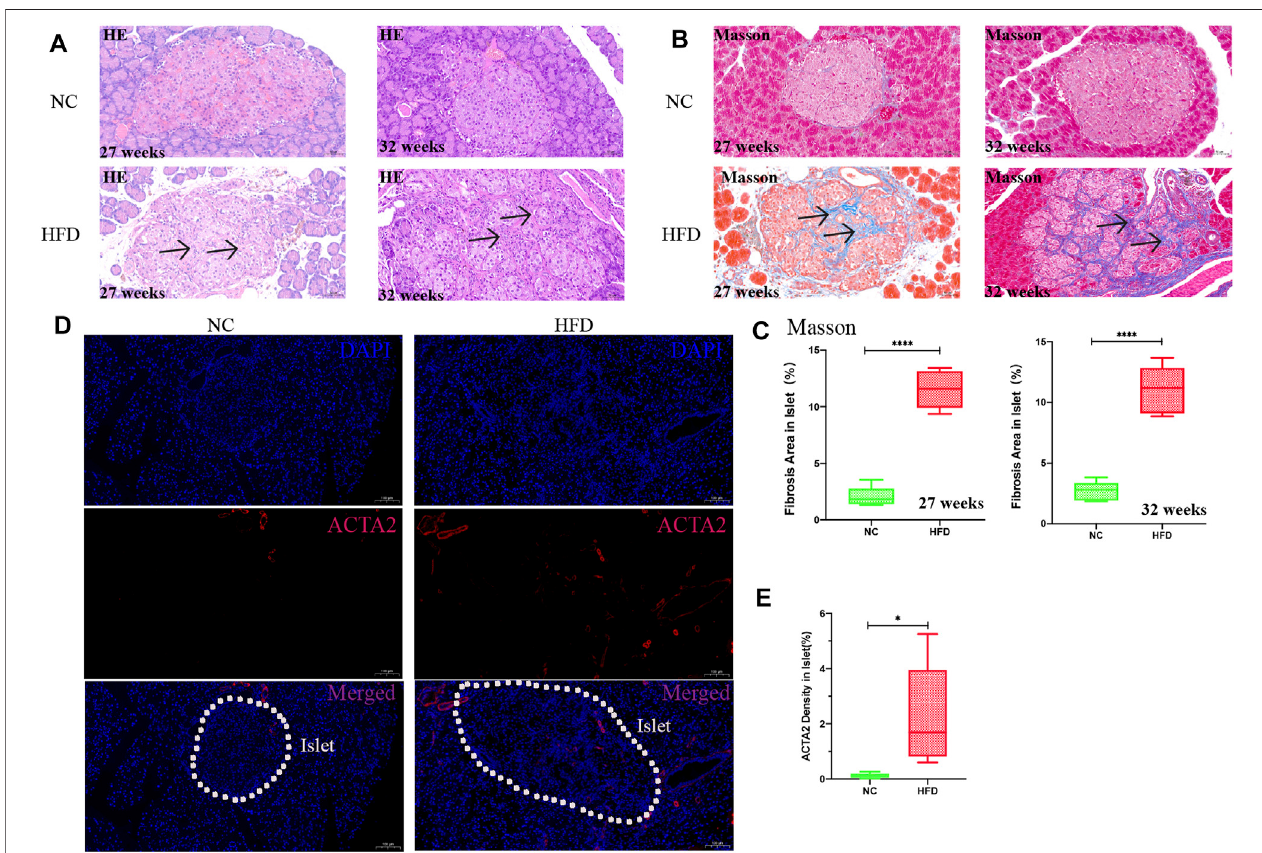
FIGURE8| Pathology and fi broticprotein detection inislets. H&Estainingand Masson stainingwereused toobservetheislet tissue,and ACTA2 wasdetectedby immuno fl uorescence. The percentage of fi brosis was calculated by dividing the area of blue fi ber within the islet parenchyma by the islet area, and the density of the ACTA2wascalculatedbydividingtheareaofred fl uorescencewithintheisletbytheisletarea.Quanti fi cationwasperformedinablindfashion. (A) H&Estaininginisletsat 27 and 32 weeks (20 × magni fi cation; scale bar: 50 µm). After HFD intervention, the area of islets varied and were mostly large or medium in size, with irregular edges and a large amount of fi brosis in the islet interstitium ( arrows ). The islets were divided into medium-sized clumps, and the cells in the islets were arranged in disorder. (B,C) Masson staining (20 × magni fi cation; scale bar: 50 µm). A large amount of collagen fi brin was visible in the islets after HFD intervention ( arrows ). (D,E) Immuno fl uorescence analysis after 27 weeks of HFD intervention. The expression of ACTA2 (red) in islets as determined by immuno fl uorescence staining was signi fi cantlyhigher intheHFDgroupthanintheNCgroup(10 × magni fi cation; scalebar:100 µm).Theresultsarepresented asthemean ± standarddeviation( t -test;n (cid:2) 6 in each group). * p < 0.05,** p < 0.01,*** p < 0.001,**** p < 0.0001, n. s., not signi fi